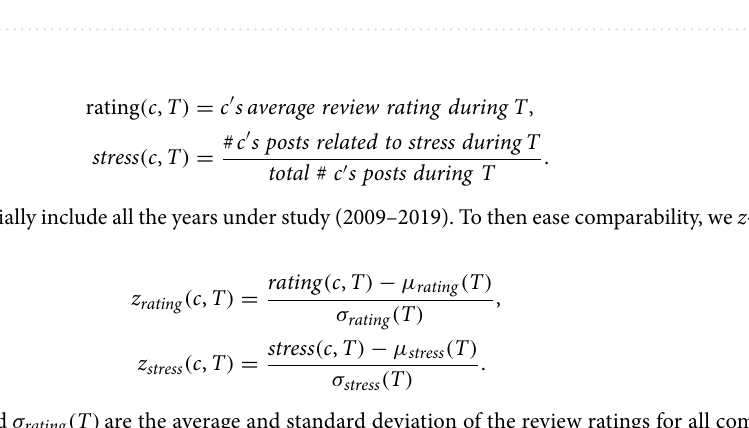
rating ( T ) stress ( T )